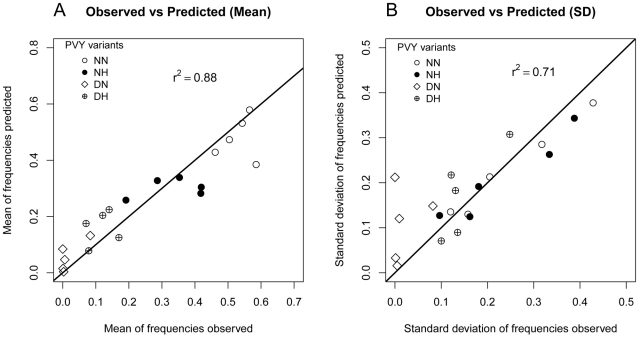
Goodness of fit of the model that is best supported by the data (model

).
A: Correlation between the 20 (4 variants×5 dates) observed mean frequencies of the four PVY variants and their estimated mean values. B: Correlation between the 20 observed standard deviations of the frequencies of the four PVY variants and their estimated standard deviations. The full line is the first diagonal (i.e. line y = x).